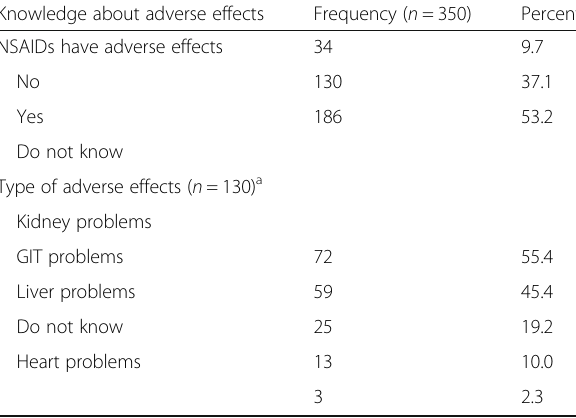
Table 3 Knowledge of CKD patients about adverse effects of NSAIDs (Alexandria Main University Hospital, Egypt,